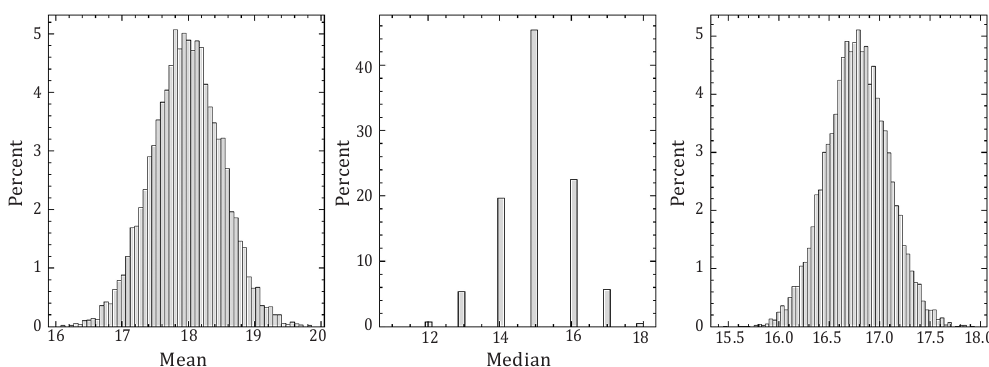
Figure 7. Mean distribution of subsample statistics ( N =